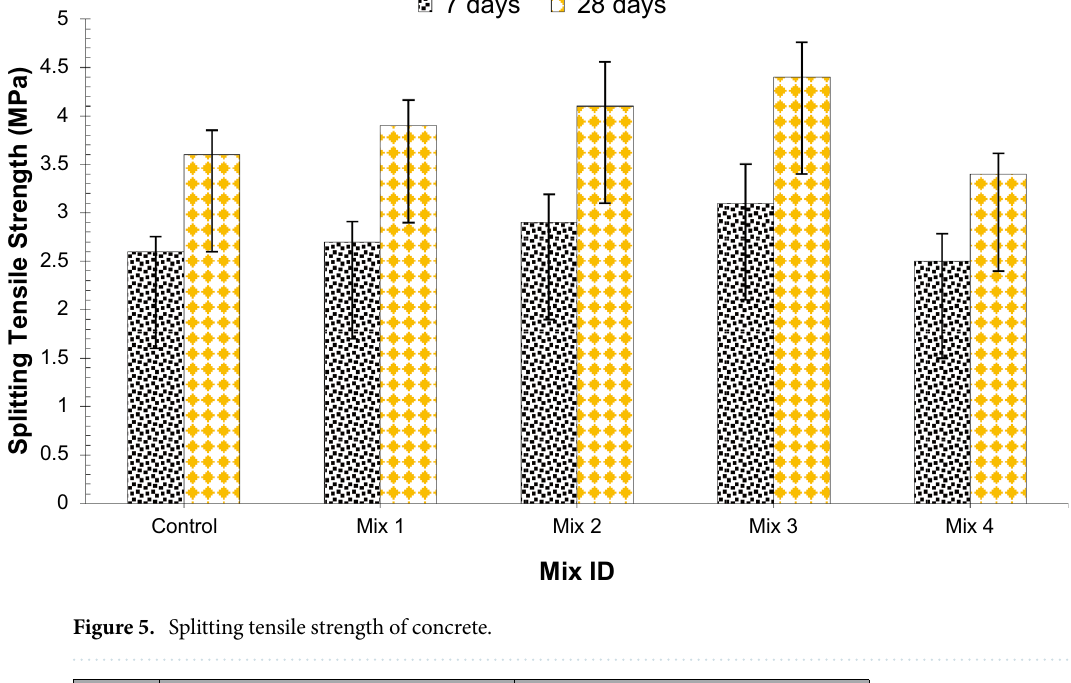
Figure 5. Splitting tensile strength of concrete. 7 days 28 days Mix ID Standard deviation Coefficient of variation Standard deviation Coefficient of variation Control